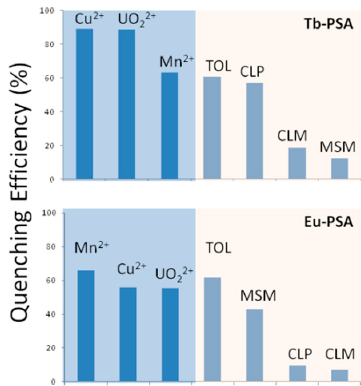
Figure 8. QE% of compounds Tb-PSA (above) and Eu-PSA (below) in the presence of different pollutants.